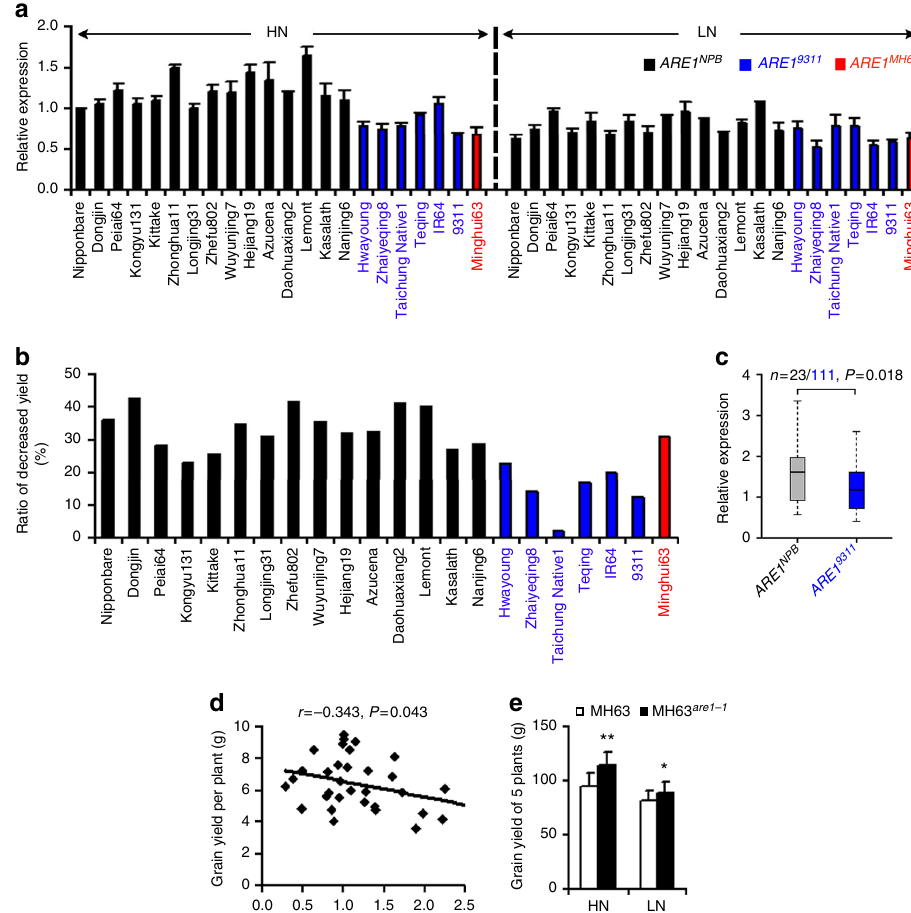
Fig. 6 Modulation of ARE1 expression and grain yield by InDel polymorphisms. a Analysis of the ARE1 expression in representative varieties with three different InDel haplotypes. Total RNA prepared from leaves of 3-week-old seedlings hydroponically grown under high nitrogen (HN; 1.46 mM NH 4 NO 3 ) or low nitrogen (LN; 0.73 mM NH 4 NO 3 ) conditions was used for qRT-PCR analysis. Data presented are mean values of three technical replicates with s.d. b The ratio (HN vs. LN) of decreased grain yield per plants shown in ( a ). c Analysis of the ARE1 expression in the Liangyoupei9 (LYP9) recombinant inbred lines (RILs; F 13 generation). The numbers ( n ) of each haplotype and P value (Student ’ s t -test) are given above the graph. Total RNA was prepared as de fi ned in ( a ) and data presented are mean values of three technical replicates with s.d. d Analysis of the correlation of grain yield with the ARE1 expression level in RILs shown in ( c ). r and P values are determined by the Pearson correlation analysis. Leaves of plants at the heading stage grown under low nitrogen conditions (150 kg/ha urea) were used for the preparation of total RNA and subsequent qRT-PCR analysis. Data presented are mean values of three technical replicates with s.d. e Gain yield of MH63 and MH63 near isogenic lines carrying an are1-1 allele (MH63 are1-1 ; BC 6 F 4 ) grown under high nitrogen (HN; 240 kg/ha) or low nitrogen (LN; 120 kg/ha) conditions. Data presented are mean values with s.d. ( n = 20 plants). *, ** P < 0.05 and P < 0.01 (Student ’ s t -test),